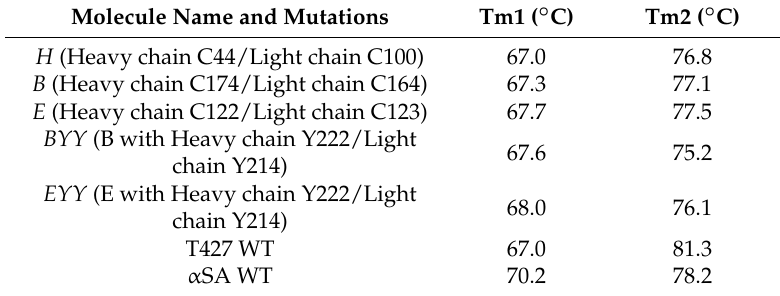
Table 3. Tm values ( ◦ C) of the bsAbs vs. their parental antibodies as determined by NanoDSF. The bsAbs all have a KIH Fc and the mutations changing the cysteines of the naturally-occurring H–L disulfide bond of the engineered Fab arm mutated to Alanine in the H chain and deleted in the Kappa light chain. In the YY mutants they are changed to tyrosine.